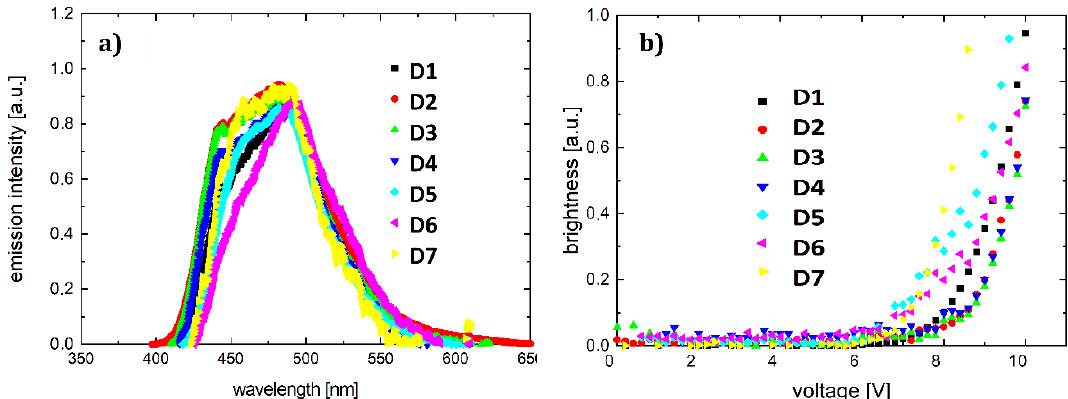
Figure 9. Electroluminescence spectra for D1–D7 ( a ) and brightness–voltage characteristics for diodes D1–D7 ( b ). Table 6. Electroluminescent parameters of the organic diodes D1–D7.